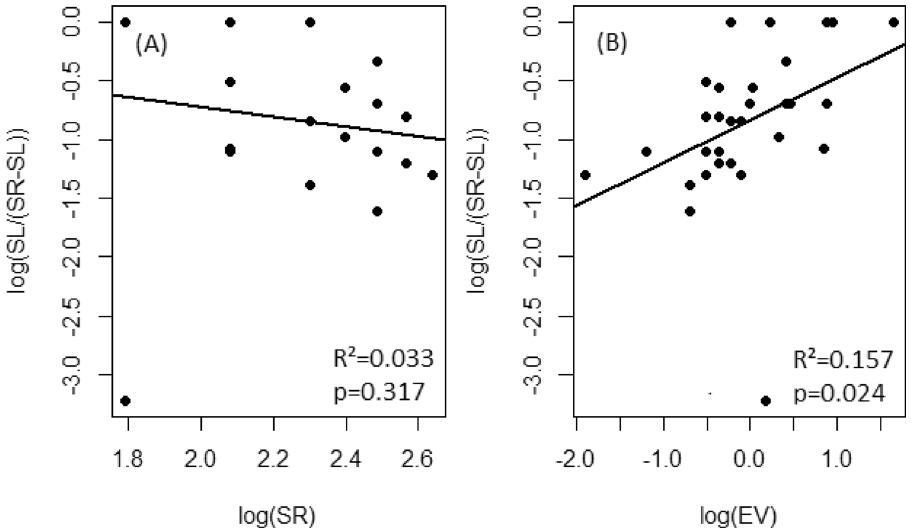
Figure 4. Log–log regression illustrating ( A ) the non-significant linear decrease in the proportion of shared richness as function of regional species pool (SR) and ( B ) the linear increase in the proportion of shared richness as function of ethnobotany value (EV). SL is the species richness of agroforestry system.